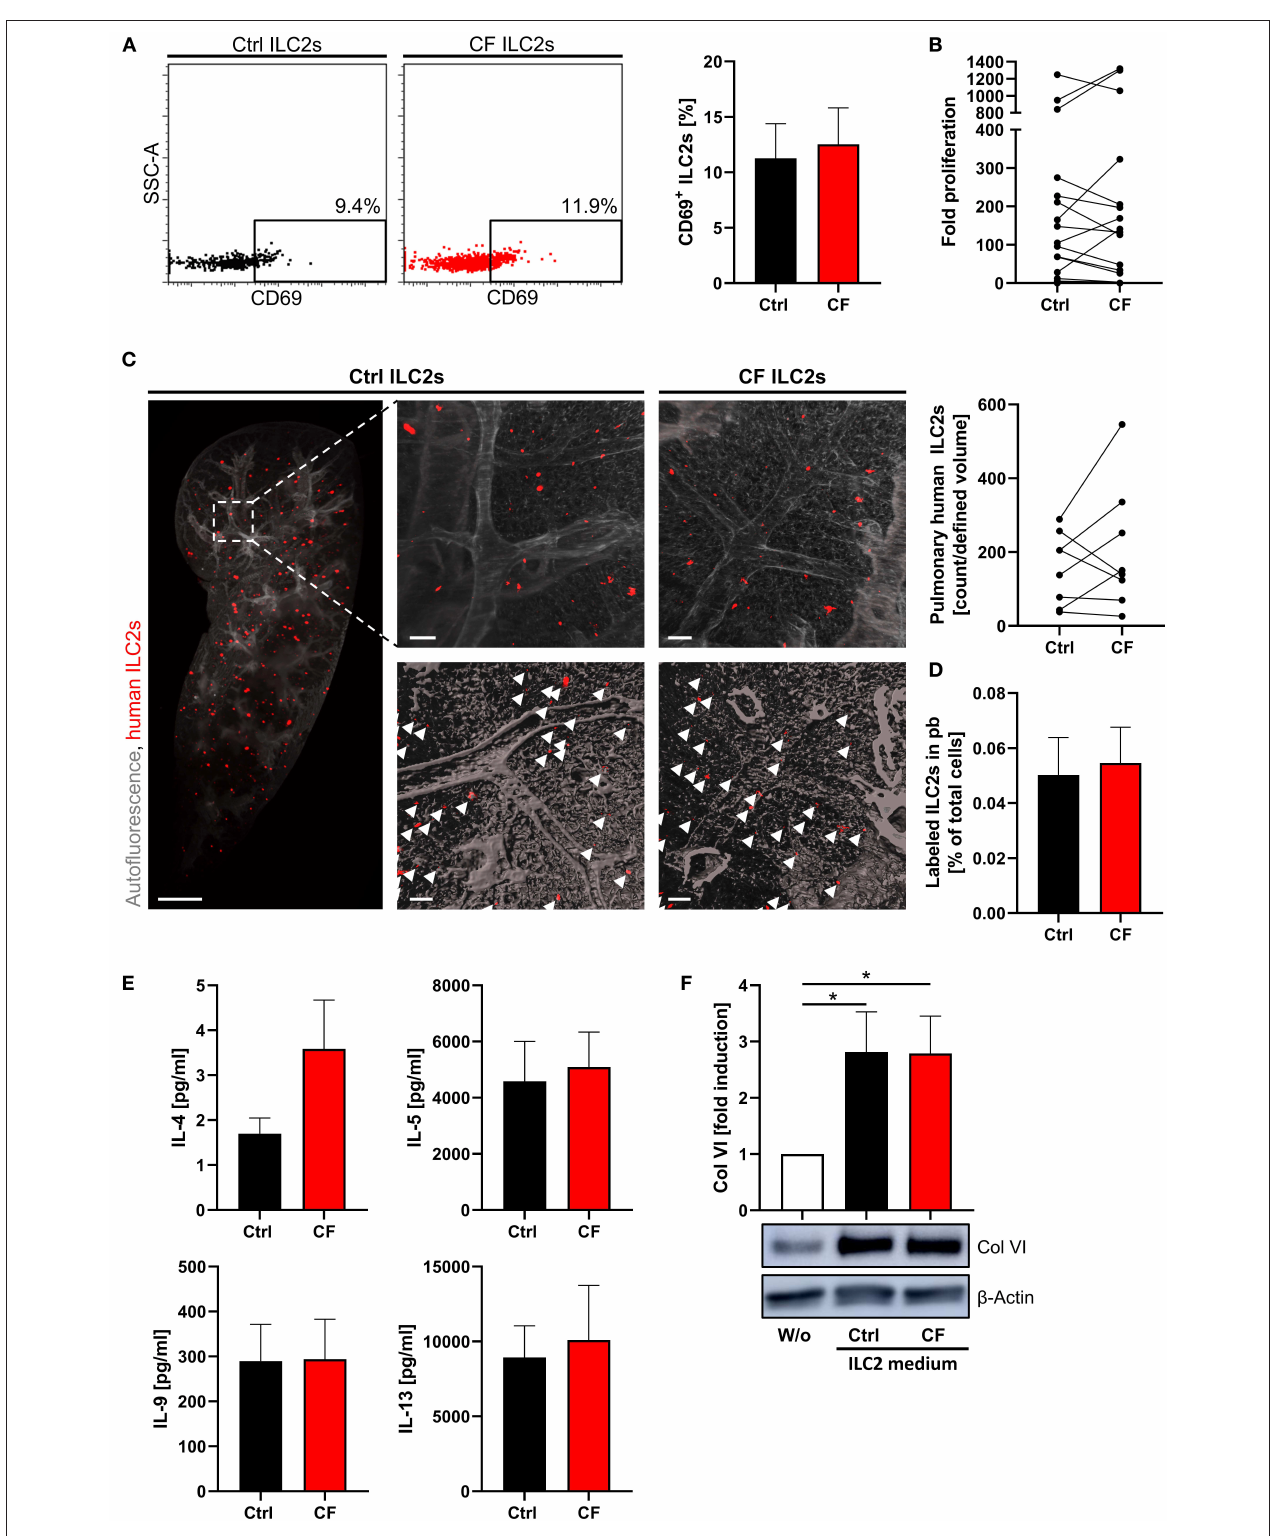
FIGURE 5 | Unaltered potent ex vivo expansion, cytokine production and lung homing capacity of human CF ILC2s. (A) Percentage of CD69 + pb ILC2s in ctrl and CF subjects ( n = 8–9) determined by flow cytometry; representative dot plots and corresponding quantification. (B) Fold proliferation of